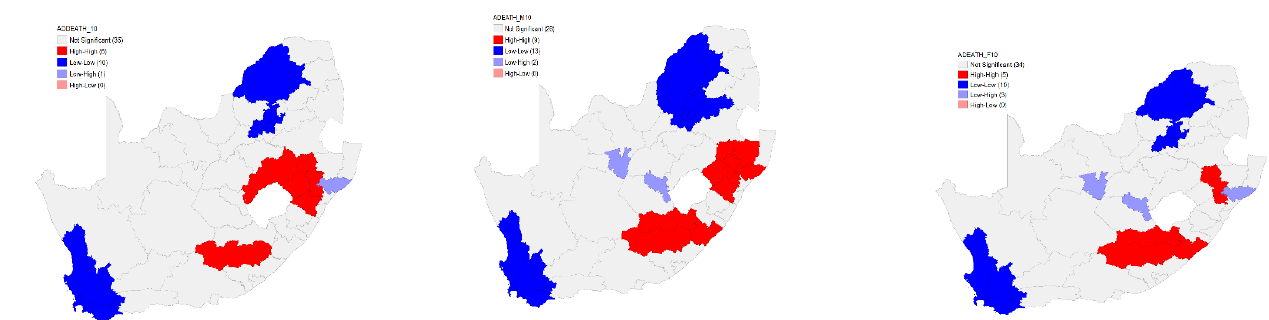
Sex Standardised TB Death Rates by District Municipality, 2010